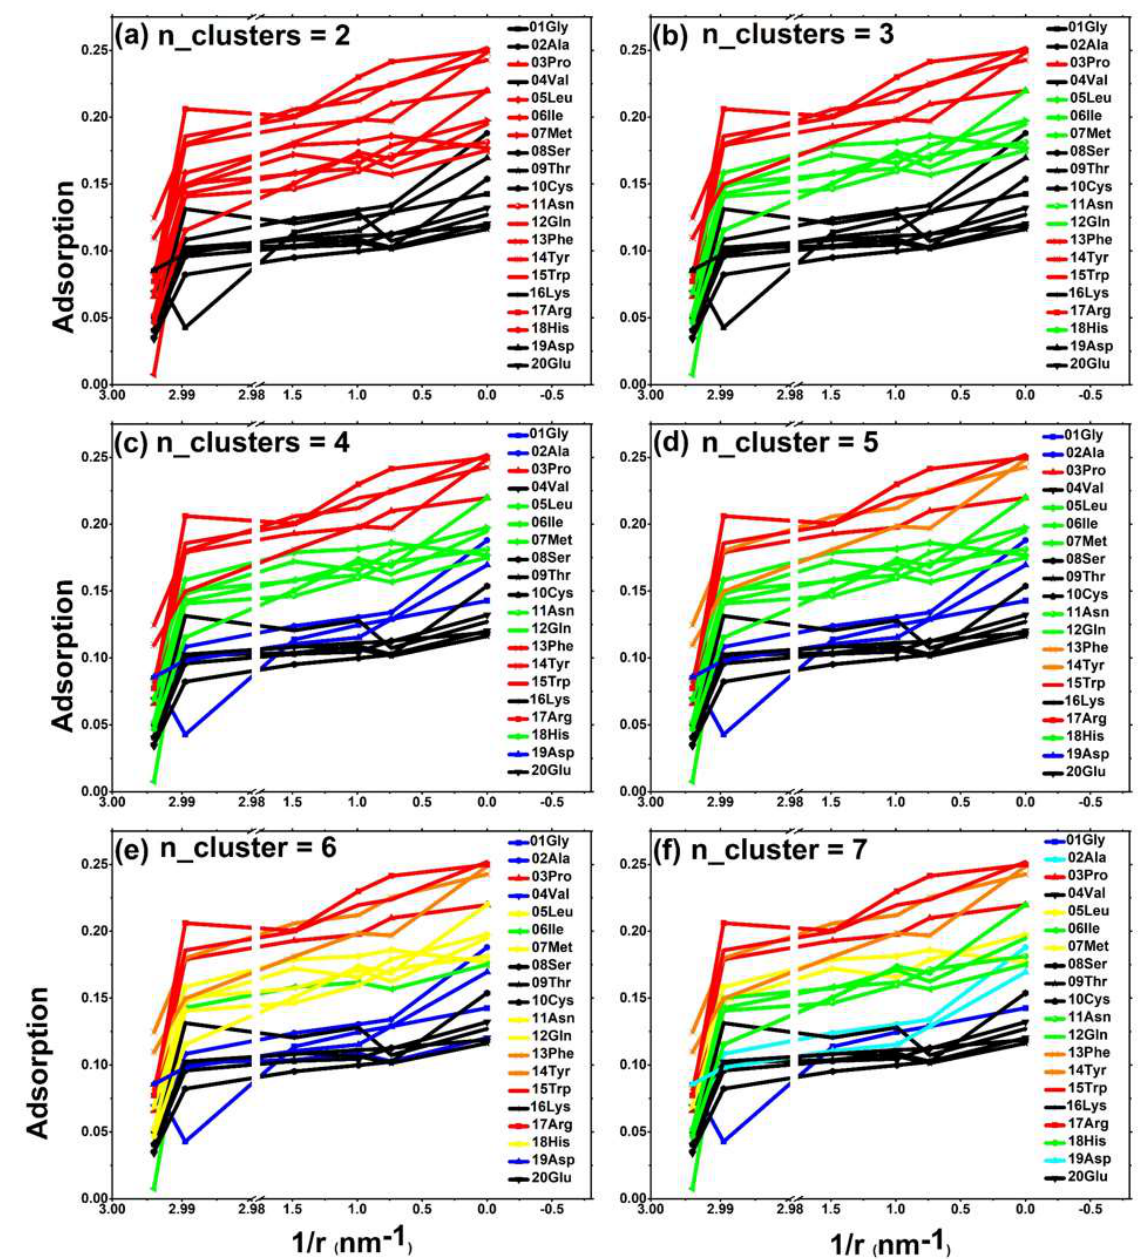
Figure 3. Multi-dimensional clustering analysis (the horizontal axis of this group of graphs is the curvature corresponding to the six types of carbon-based nanoparticles), clustering the peak distribution peaks of the 20 amino acids to the nearest distance of the carbon-based nanoparticles: ( a ) n_cluster = 2; ( b ) n_cluster = 3; ( c ) n_cluster = 4; ( d ) n_cluster = 5; ( e ) n_cluster = 6; ( f ) n_cluster = 7. The colors of the lines with cluster scores from high to low are a red dotted line, orange dotted line, yellow dotted line, green dotted line, bright blue dotted line, dark blue dotted line, and black dotted line.